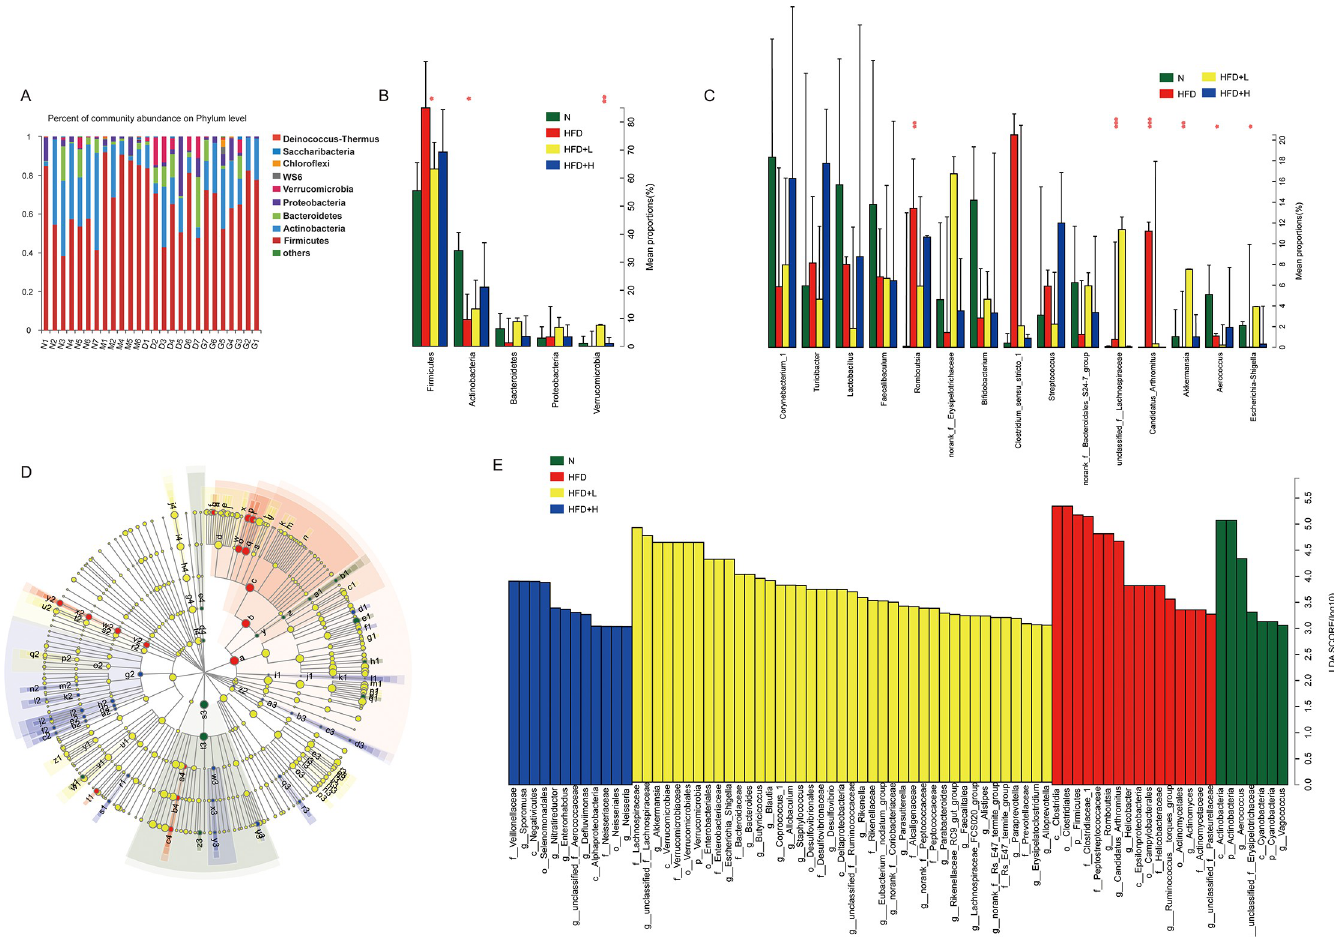
Fig 3. Effects of YNKB on gut microbiota relative proportion in HFD-induced ApoE-/- mic at phylum level. (A) The main microbiota and their relative proportions in different groups. Data are presented as means. The top five and fifteen microbiotas and their relative proportions in different groups at phylum level (B) and genus level (C). Differences in dominant microorganisms among groups were shown in (D) Cladogram and (E) Distribution histogram based on LDA. � p < 0.05, �� p < 0.01 among the four groups.